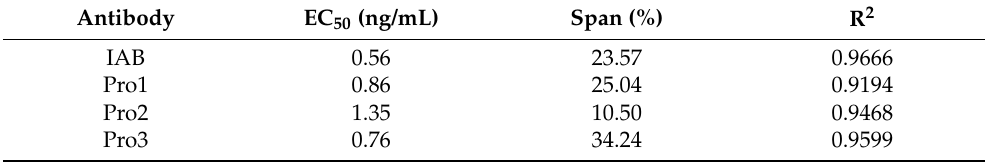
Table 3. Dual-targeting proteins retained ADCC cytotoxicity towards MDA-MB-231 cells (E:T = 40:1).